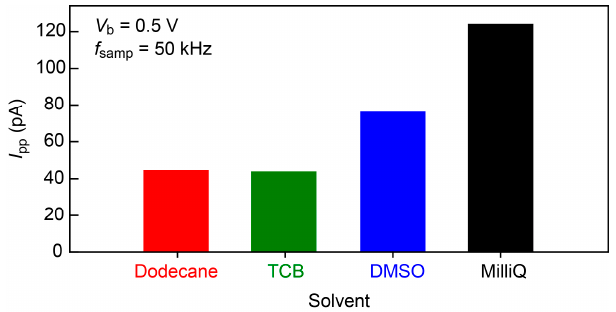
Figure 4. Solvent dependence of current noise measured with 1 nm-sized SiO 2 -protected Au electrode gaps. Sampling rate was 50 kHz. 100 kHz low pass filter was used for the current measurements. The noise is described as peak-to-peak values obtained in dimethyl sulfoxide (DMSO), dodecane, 1,2,4-trichrolobenzene (TCB), and Milli-Q.